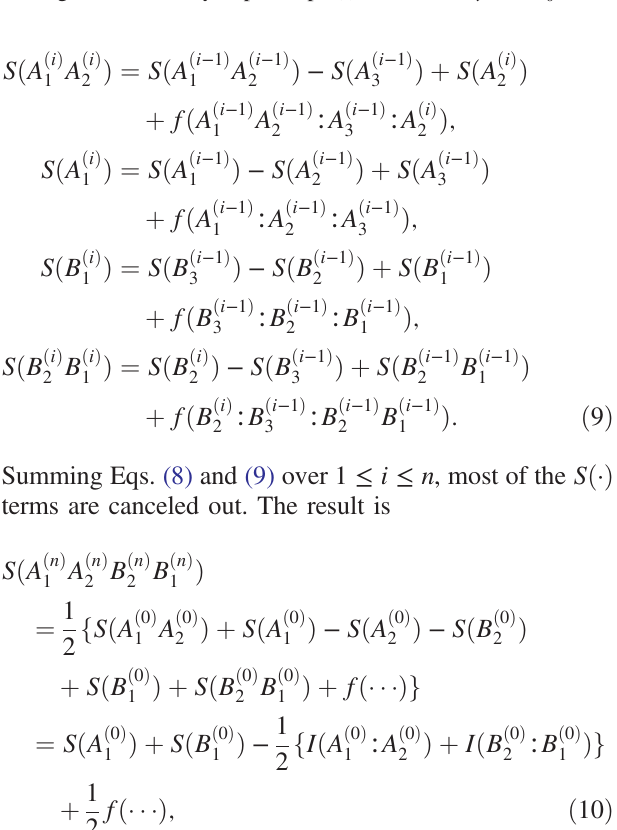
ð i Þ ð i − 1 Þ ð i − 1 Þ 1 ¼ B 3 þ B 1 . Each region denoted by superscript ( i ) is of size